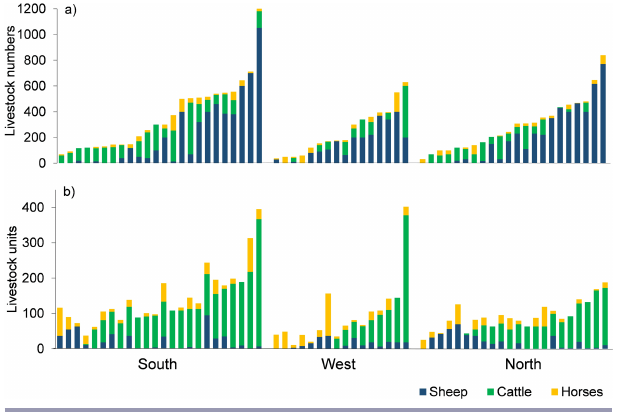
Fig. 3 . Variation in (a) numbers and (b) livestock units of sheep, cattle, and horses on study farms in the three